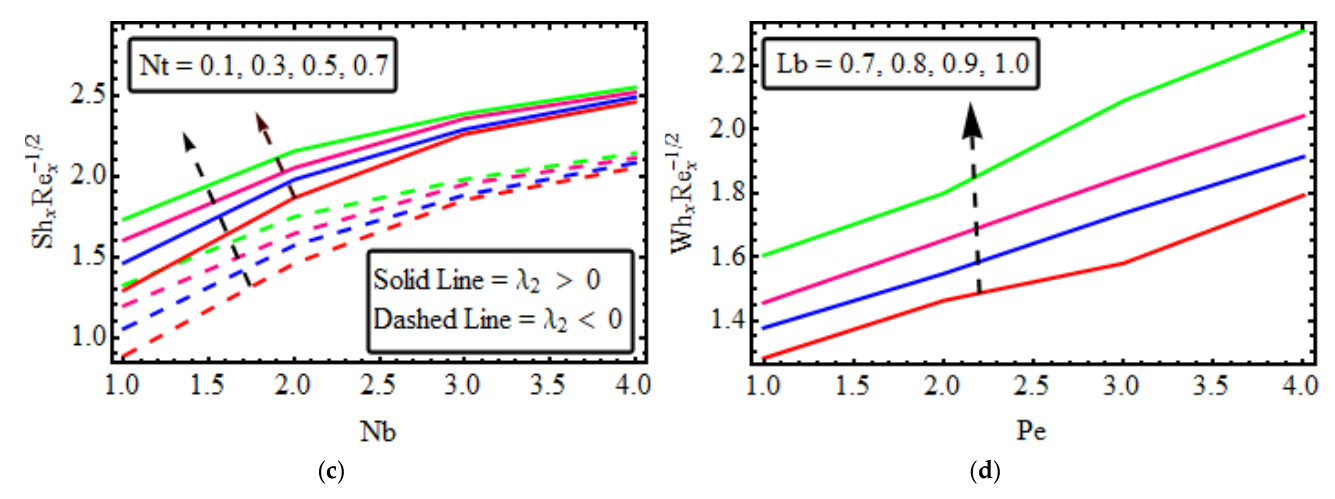
Figure 9. ( a – d ) Variation in Re 1/2 x Cf , Re − 1/2 x , Nu Re − 1/2 x Sh, Re − 1/2 x Wh x numerous variables ( a ) Z , δ ( b ) Nb , Υ ( c ) Nb , Nt ( d ) Lb , Pe . Table 2. Numerical outcomes of − θ ( 0 ) When Pr = Sc = 10, Bi = 0.1. Ali and Zaib [58] Bvp4c Current Result (HAM)